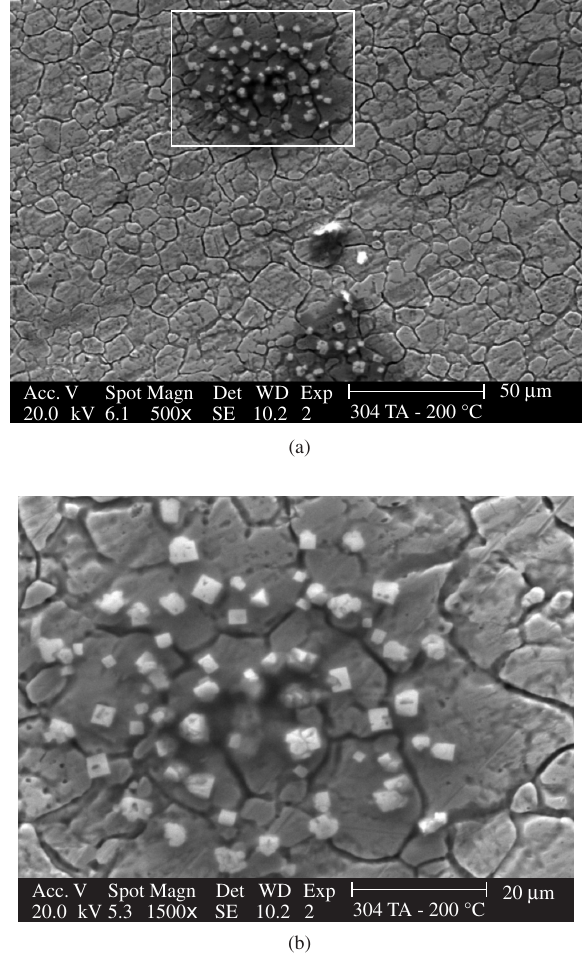
Figure 1. a) Superficial characterization of the AISI 304 steel, sample heat treated from room temperature up to 200 °C; and b) Enlarged detail of the Figure 1a.